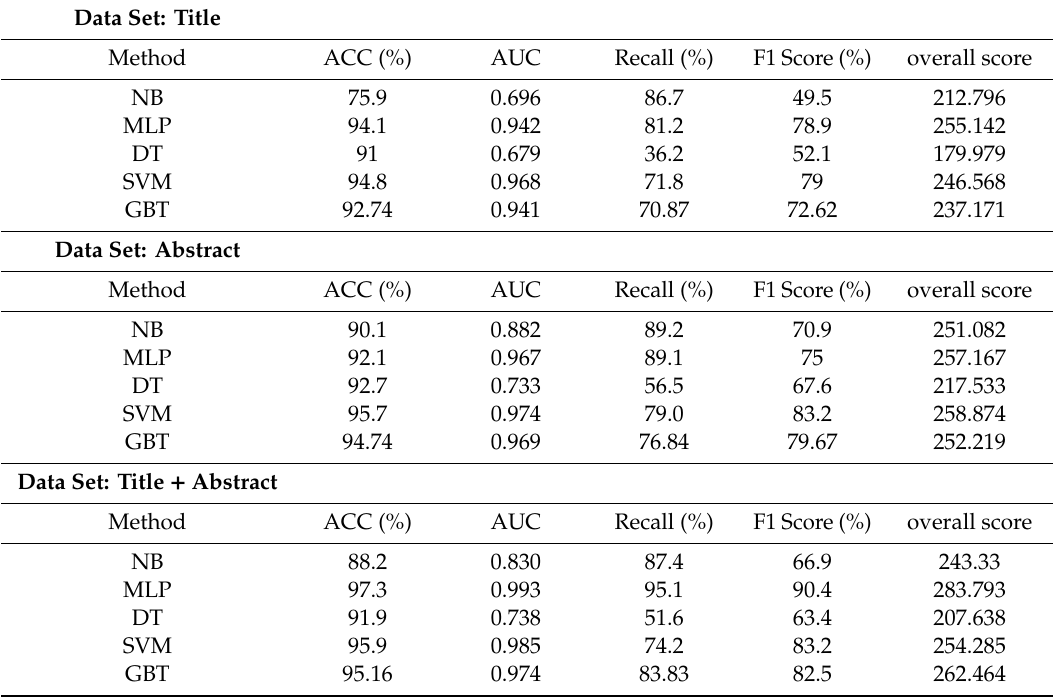
Table 3. Results for learning methods on hold-out